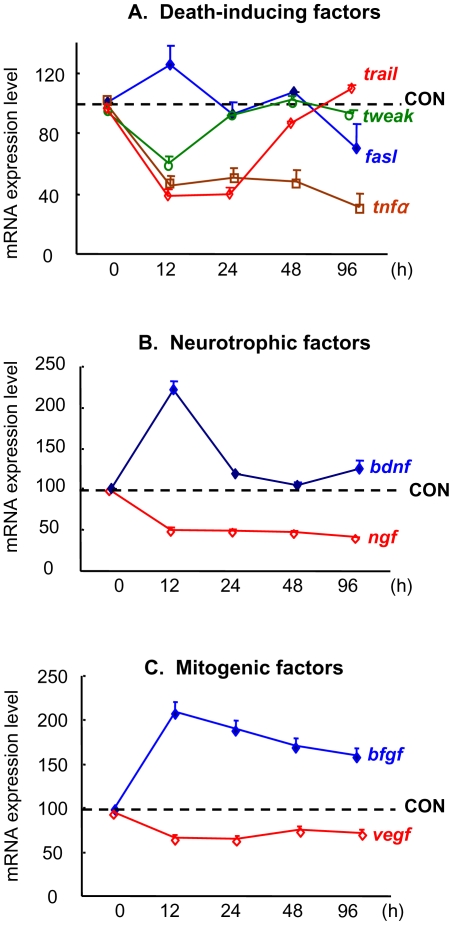
Temporal mRNA expression profiles of growth- and survival-regulating peptides in GC-treated astrocytes.
A, molecules implicated in the extrinsic death pathway; FasL mRNA was transiently increased, TRAIL and TWEAK mRNAs showed transient reductions and TNFα mRNA showed a sustained reduction after application of GC. B, expression patterns of the mRNAs encoding the neurotrophic factors BDNF (transient upregulation) and NGF (sustained downregulation) after GC treatment. C, levels of mRNA encoding for the mitogenic factors bFGF (increased) and VEGF (decreased) following exposure of astrocytes to GC. In all analyses, gapdh and actin served as housing-keeping gene controls. Values shown derive from 3 independent experiments (mean ± SD).